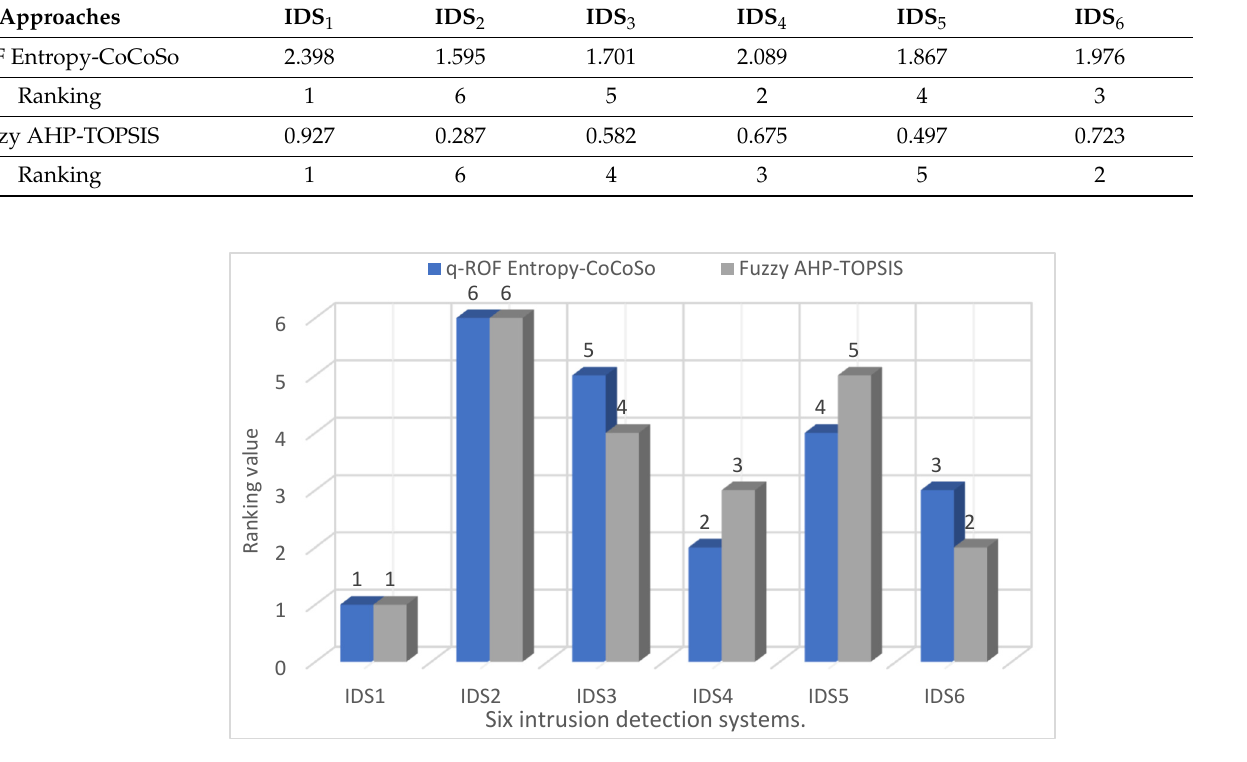
Figure 7. Final ranking of the six IDSs using various approaches.